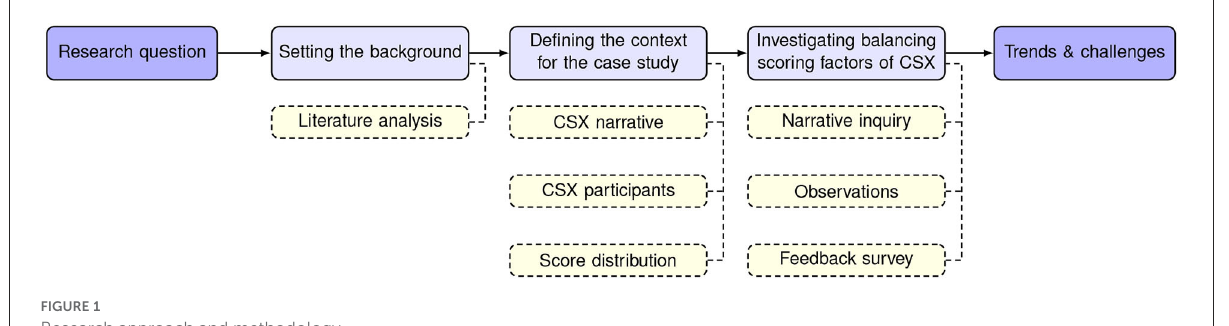
FIGURE1 Research approach and